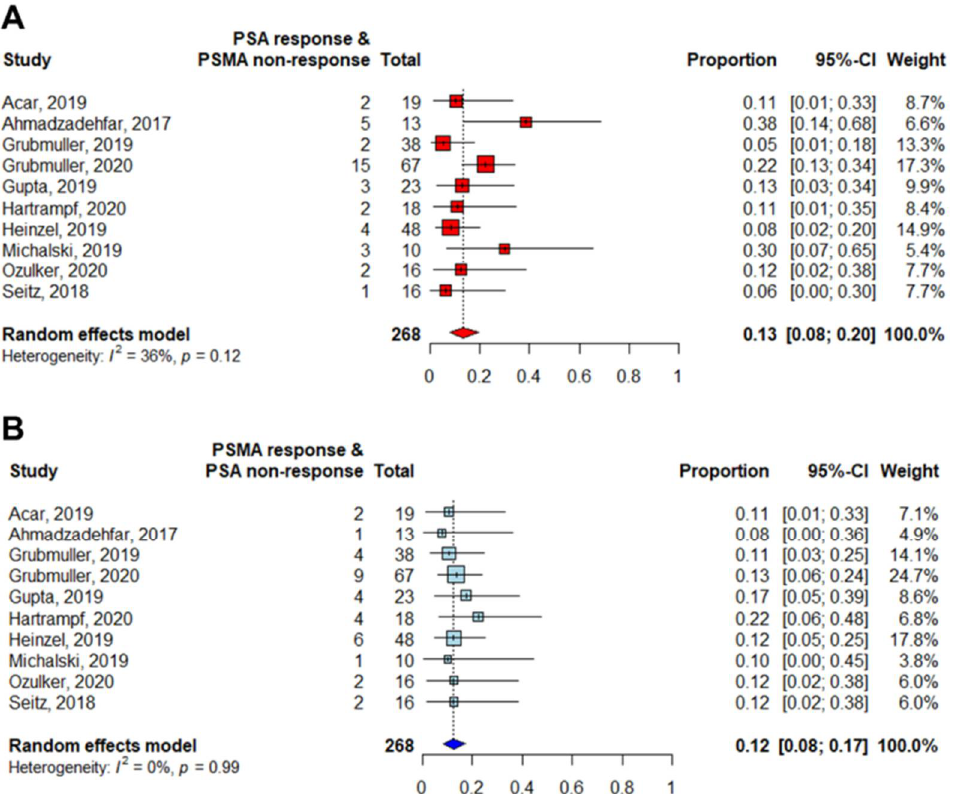
Figure 6. Forest plots of the proportions (discordant/total number of patients) of discordant responses between PSA and PSMA PET: ( A ) PSA response and PSMA non-response. ( B ) PSMA response and PSA non-response.